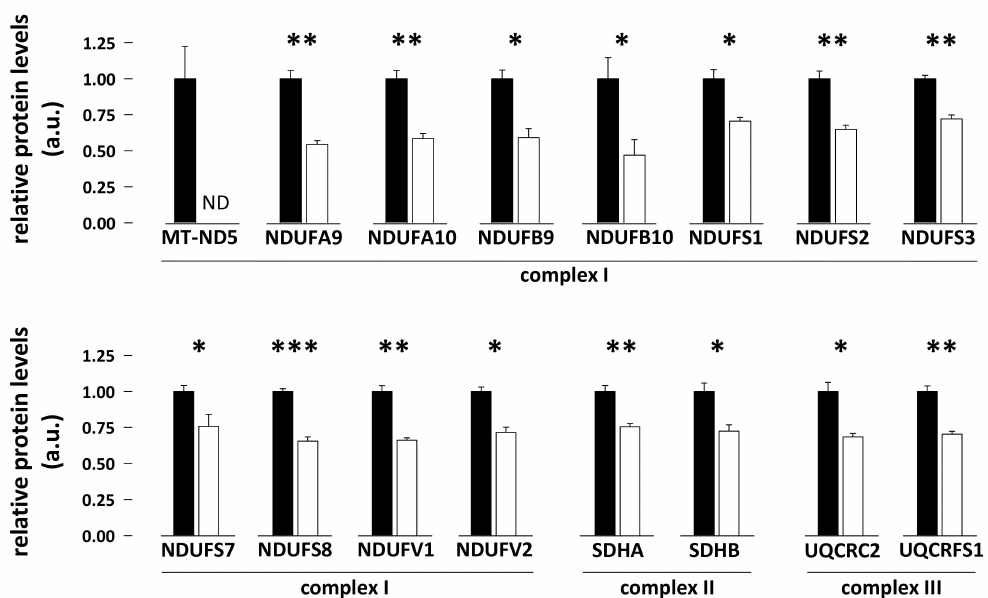
Figure 2. Protein abundance of subunits of mitochondrial respiratory complexes I, II, and III in bear skeletal muscle. Levels of subunits of the mitochondrial electron transfer chain (ETC) complex I, II, and III were measured using proteomics in vastus lateralis muscle samples from summer-active (black bars) and hibernating (white bars) brown bears [58]. Data (N = 7 / group) are expressed as means ± sem, with values in the hibernating period being normalized to those in the summer-active condition, which were arbitrarily set to 1. Statistical significance is shown for paired student t -tests (* p < 0.05; ** p < 0.001; *** p < 0.0001). a.u.: arbitrary units; ND: below the detection